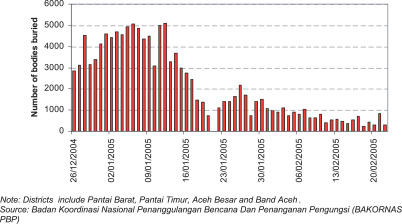
Daily Number of Bodies Buried in Banda Aceh and Surrounding Areas, 26 December 2004 to 22 February 2005Districts include Pantai Barat, Pantai Timur, Aceh Besar, and Band Aceh.(Source: Badan Koordinasi Nasional Penanggulangan Bencana Dan Penanganan Pengungsi—BAKORNAS PBP)